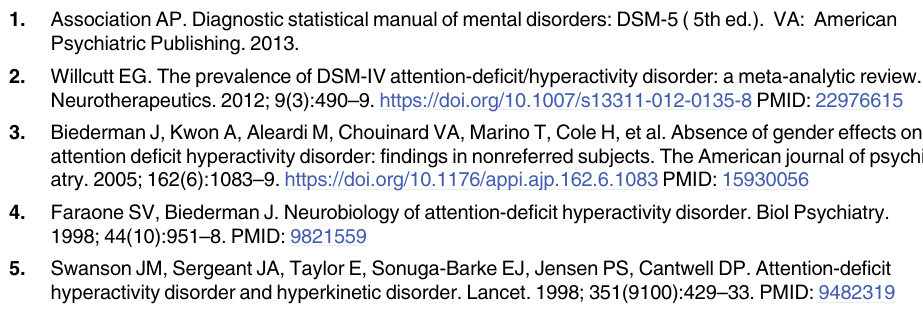
S3 Table. Association between individual SNP and ADHD risk in discovery stage. Abbrevi- ations: Ref, Reference allele; HW, wild type homozygote; HT, heterozygote; HV, variant homo- zygote; OR, odds ratio; CI, confidence interval. a All the P values were adjusted for age and gender. The significant level was corrected with the formula of α ’ = α /15 (cid:3) 5 = 0.00067 accord- ing to the Bonferroni method. The nominal significant results were in bold. S4 Table. Correlations between candidate SNPs and ADHD subtype in stage one. a All the P values were adjusted for age and gender. The significant level was corrected with the formula of α ’ = α /15 (cid:3) 3 = 0.0011according to the Bonferroni method. The nominal significant results were in bold. S5 Table. Association of candidate SNPs genotypes with PSQ score in stage one. a compared with ANOVA analysis, posthoc comparisons with SNK. The significant results were in